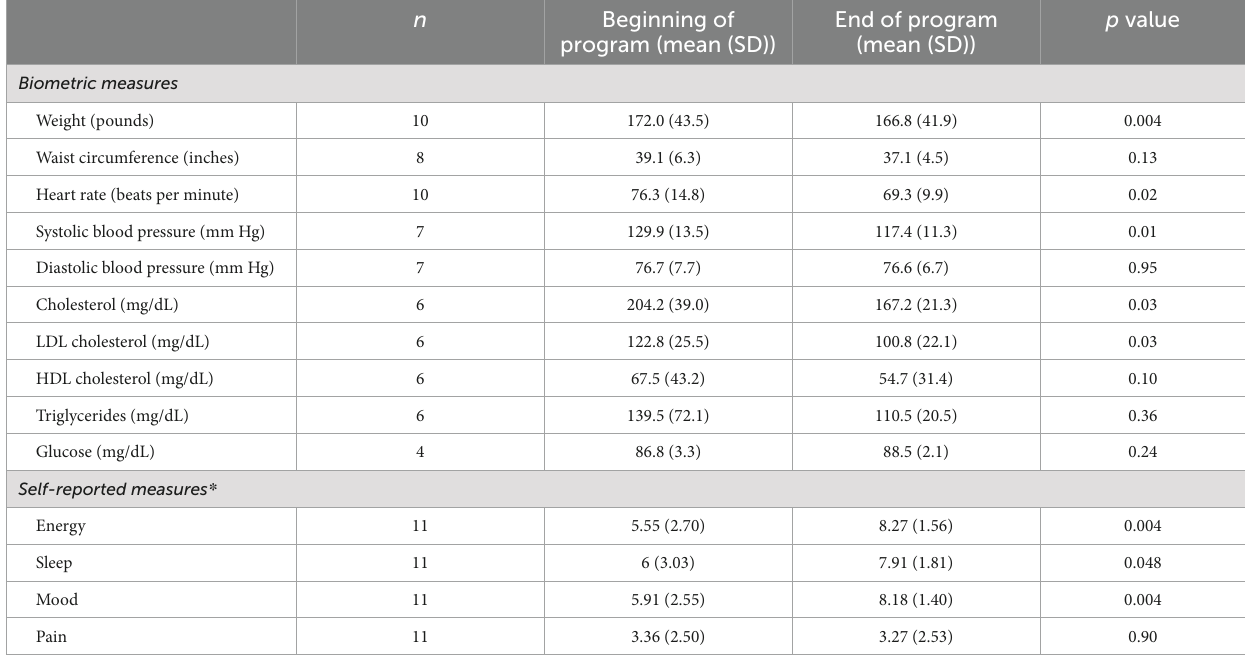
TABLE 3 Jumpstart outcomes.